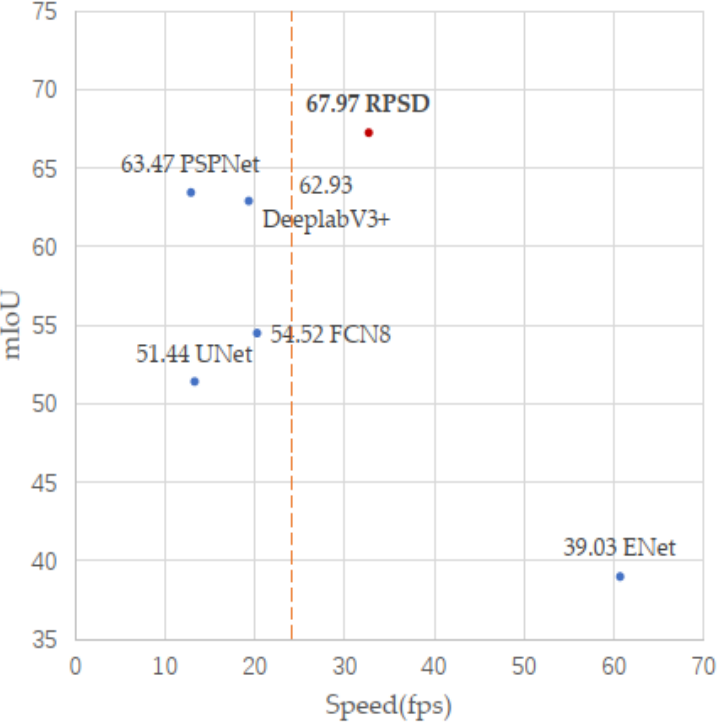
Figure 6. The performance of each network’s Speed and mIoU. The x -axis is Speed, the y -axis is mIoU, and the red dotted line is the real-time dividing line (when the network inferred frame rate is 24). The red dot in the image is the output result of our network. The network has reached the highest mIoU for the PSV dataset and has real-time performance with an inferred frame rate of 32 frames.